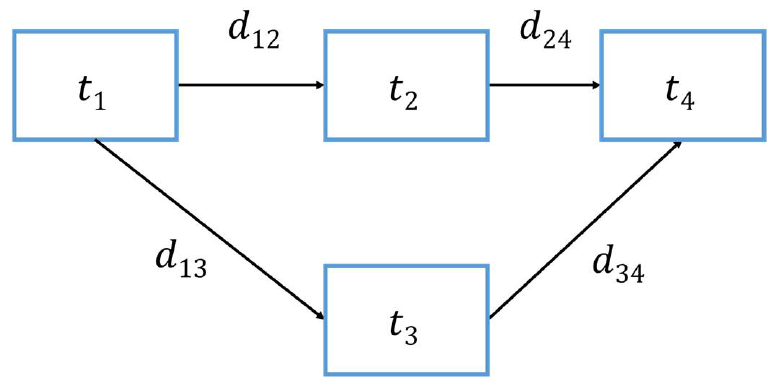
Figure 3. TS-IoT application graph.